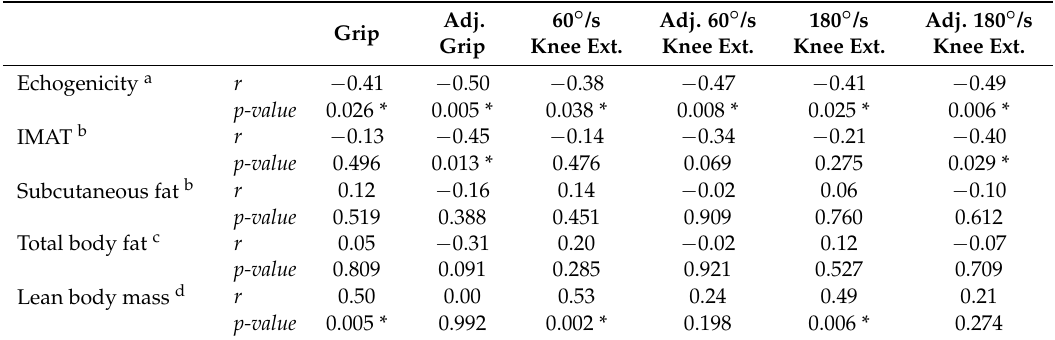
Adj. 60 ◦ /s Grip Grip Knee Ext.